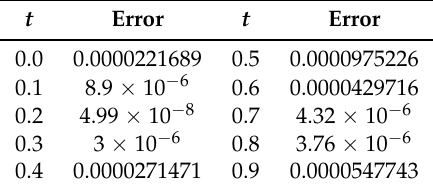
Table 3. Absolute errors in solution of System (13) with r = 3 and q = 4.